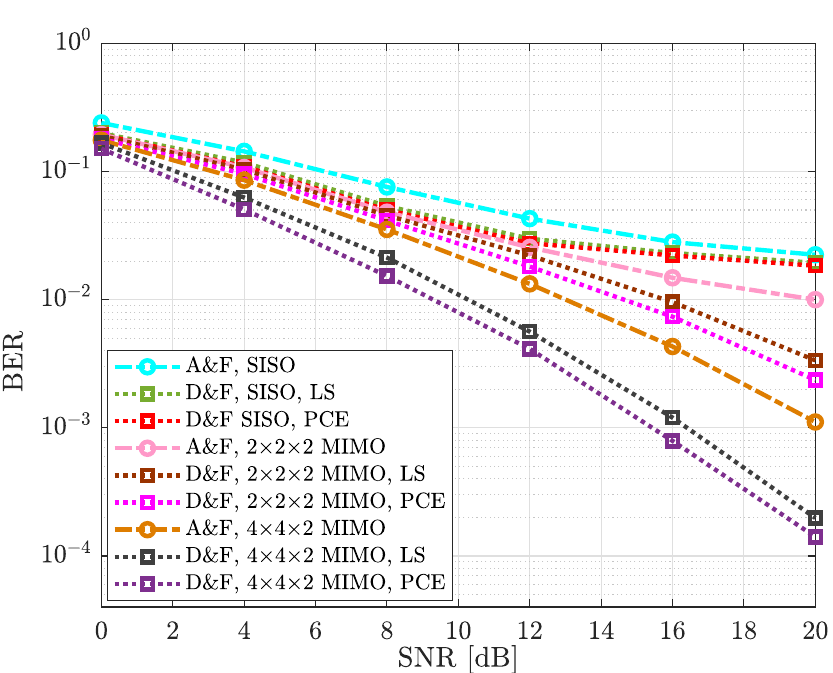
Figure 10. Bit Error Rate (BER) vs. Signal-to-Noise Ratio (SNR) of the cooperative system; 64-QAM signal.